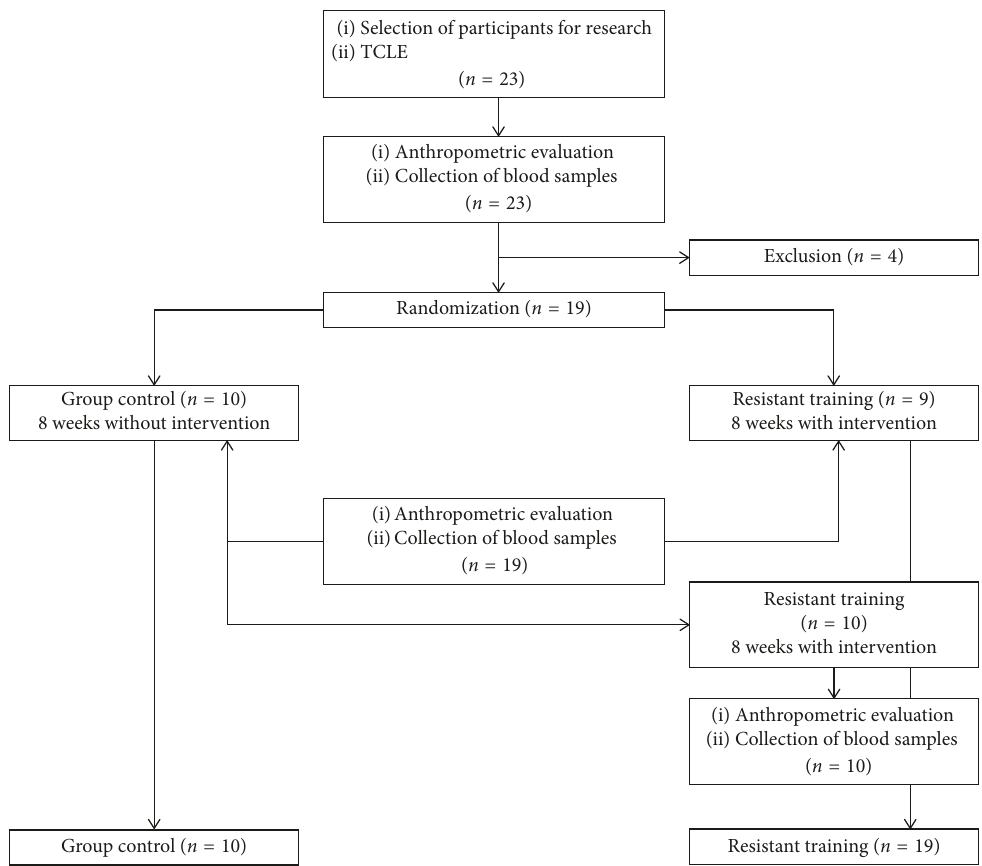
Figure 1: Study design